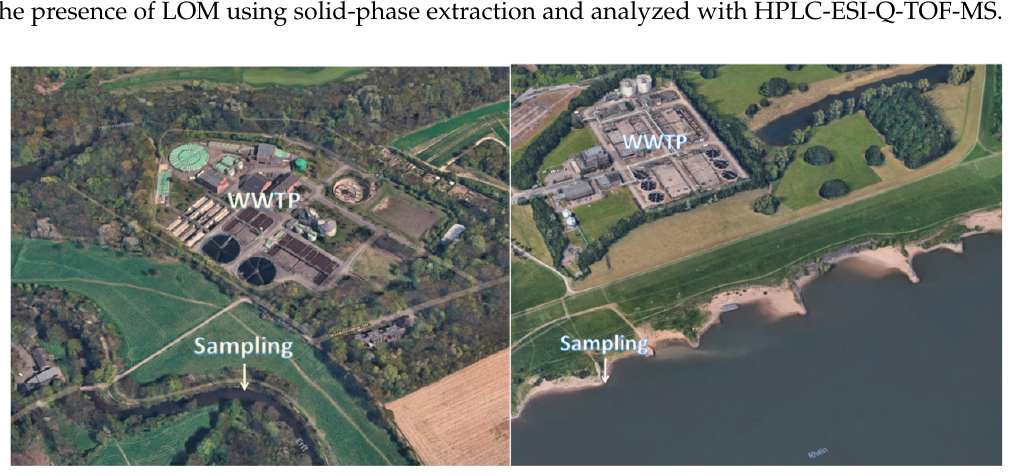
Figure 1. Sampling of the river Erft (left) and Rhine (right) near a WWTP, (pictures: © 2018 Google, GeoBasis-DE/BKG (© 2009), Google).